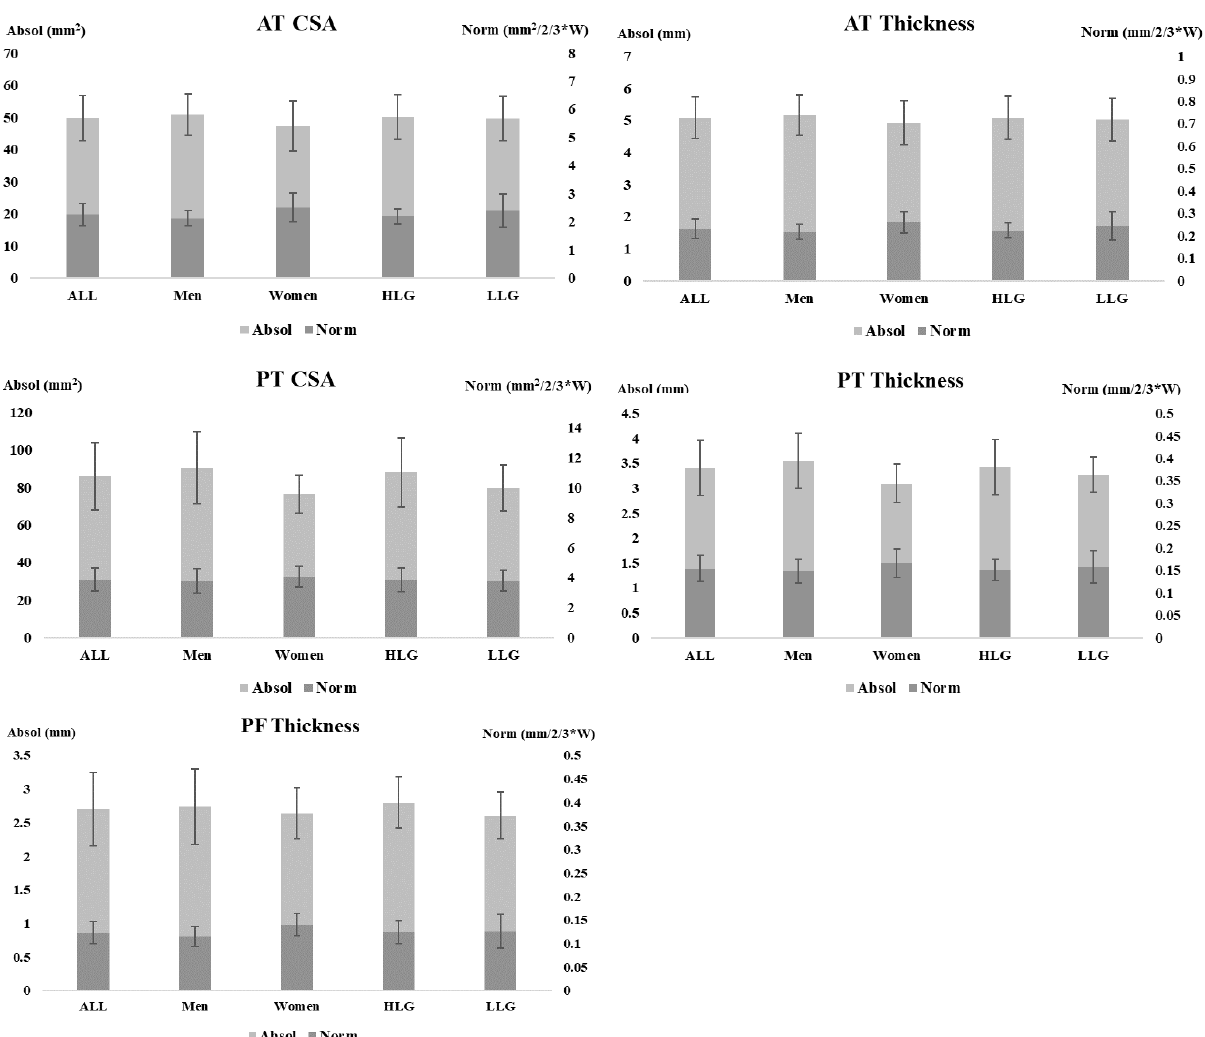
Figure 1. Comparative between normalized to body mass values vs. absolute values for connective tissue. ALL: Full sample; Absol: Connective tissue absolute values; Norm: Connective tissue normalized values; PT: Patellar tendon; AT: Achilles tendon; PF: Plantar fascia; CSA: Cross-sectional area; HLG: higher athletic-level group; LLG: lower athletic-level group. W: